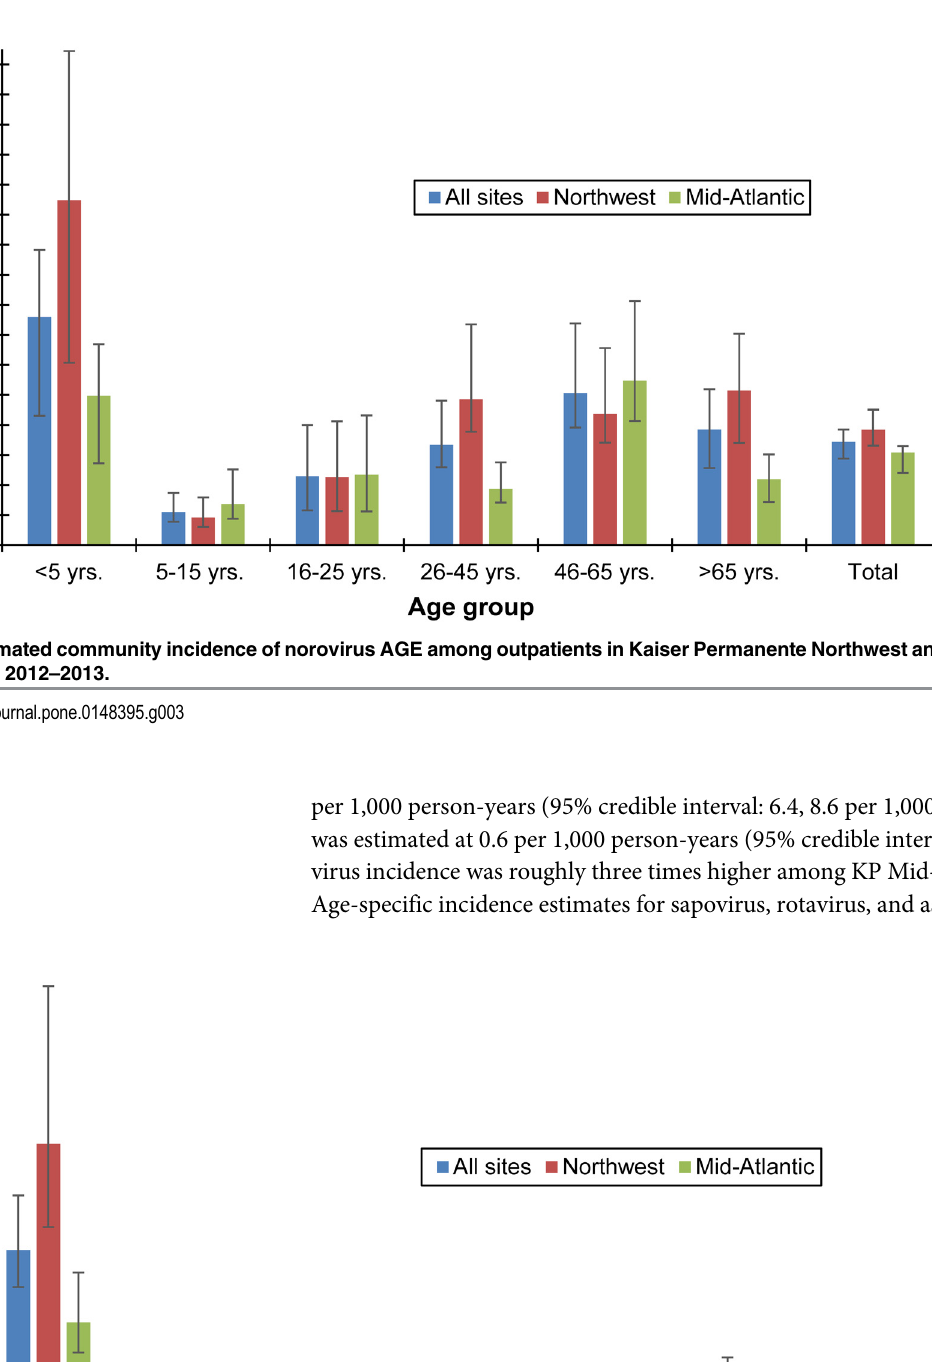
PLOS ONE | DOI:10.1371/journal.pone.0148395 April 26,